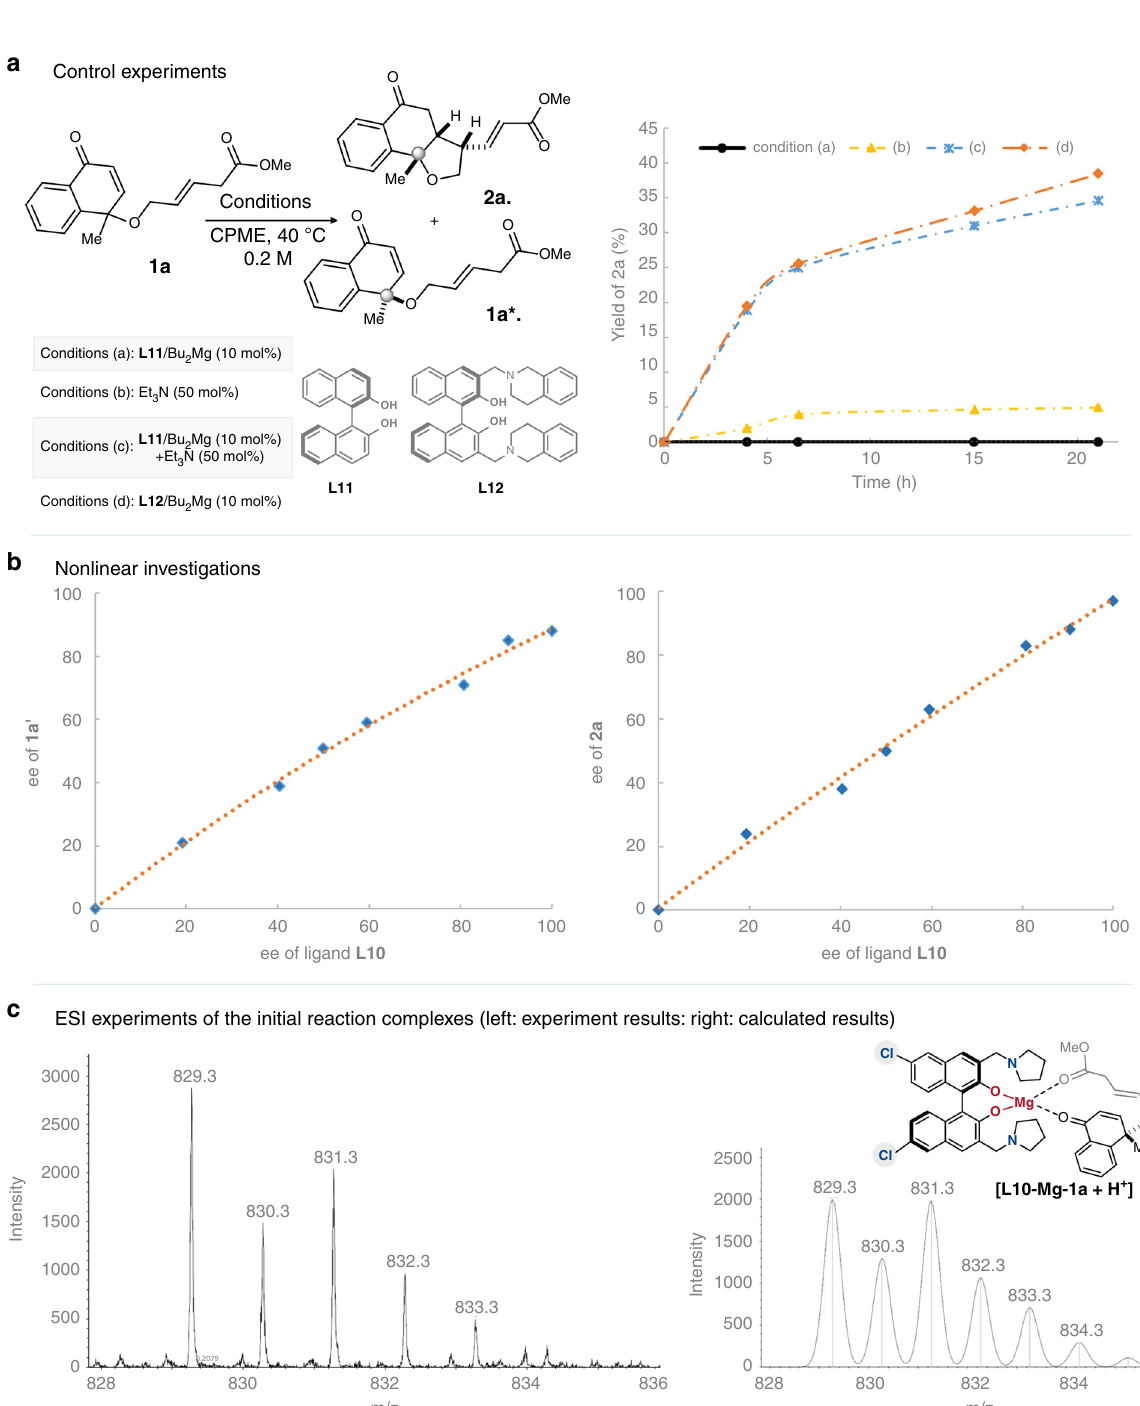
Fig. 8 Mechanistic studies for the synergistic catalyst in the KR reaction. a Control experiments of the KR reaction under different catalytic conditions. b Nonlinear effects studies of the KR reaction. c ESI experiments of the initial reaction complexes to investigate the activation proposal of a possible mechanism of this intramolecular vinylo- gous KR reaction. Further developments of the reported syner- gistic magnesium catalyst in asymmetric reactions are underway in our laboratory.